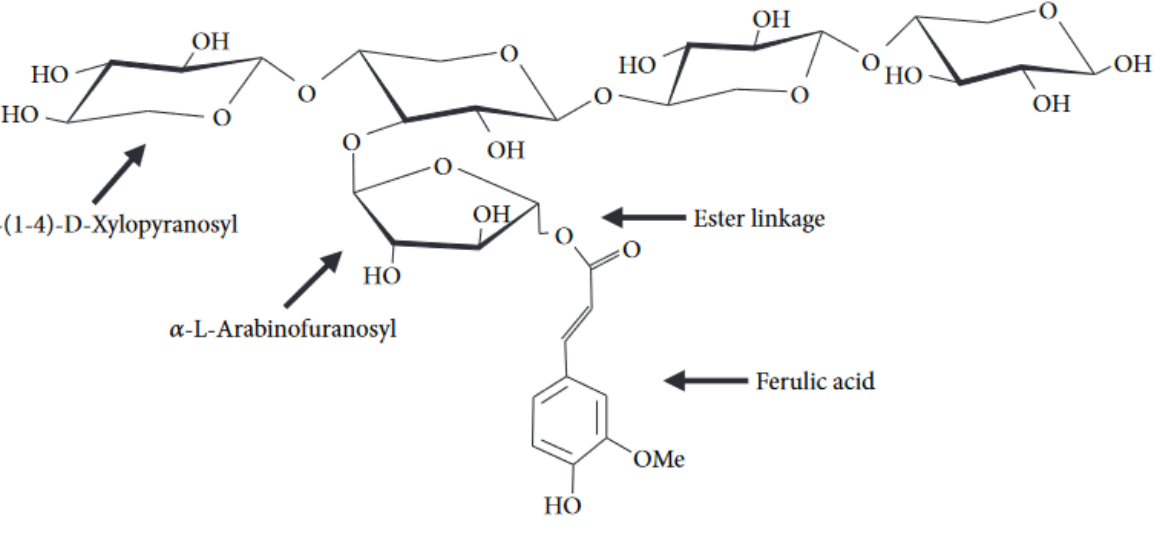
Figure 2. Arabinoxylan structure.